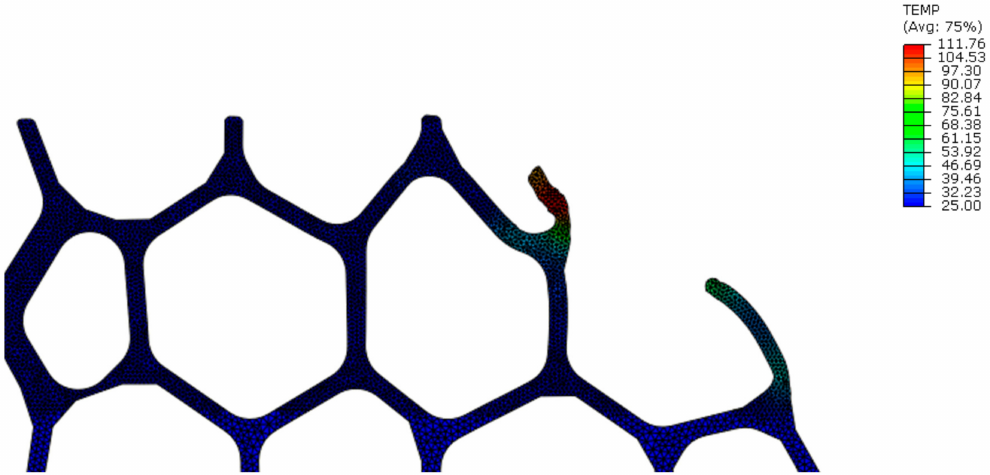
Figure 14. Temperature distribution in the region surrounding the tool path in up milling (temperature T ( ◦ C), Model A, v c = 400 m / min, f z = 0.30 mm): after 1st